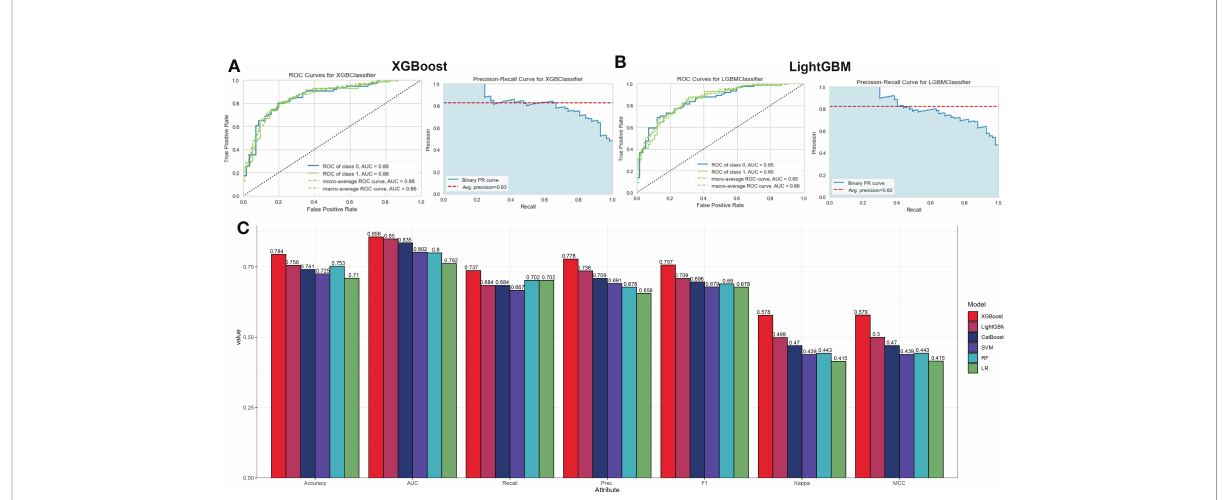
FIGURE 5 Evaluation the performance of the six machine learning algorithms in testing set. (A, B) The speci fi c values of AUC and P-R in XGBoost (A) and LightGBM (B) , machine learning models. (C) Comprehensive estimate the performance of the six machine learning models including accuracy, recall, precision, F1, kappa, and